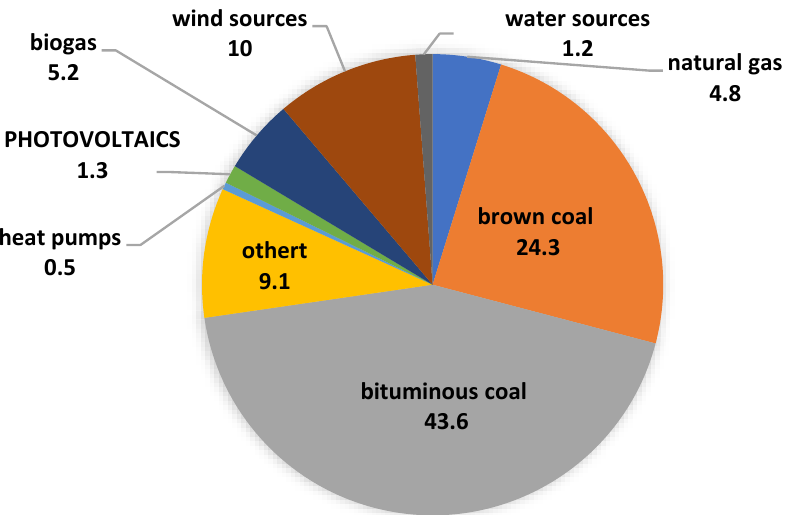
Figure 1. Power generation structure in 2020 (in %). Source: The Energy Market Agency (https://www.are.waw.pl/, accessed on 1 June 2021) [43].